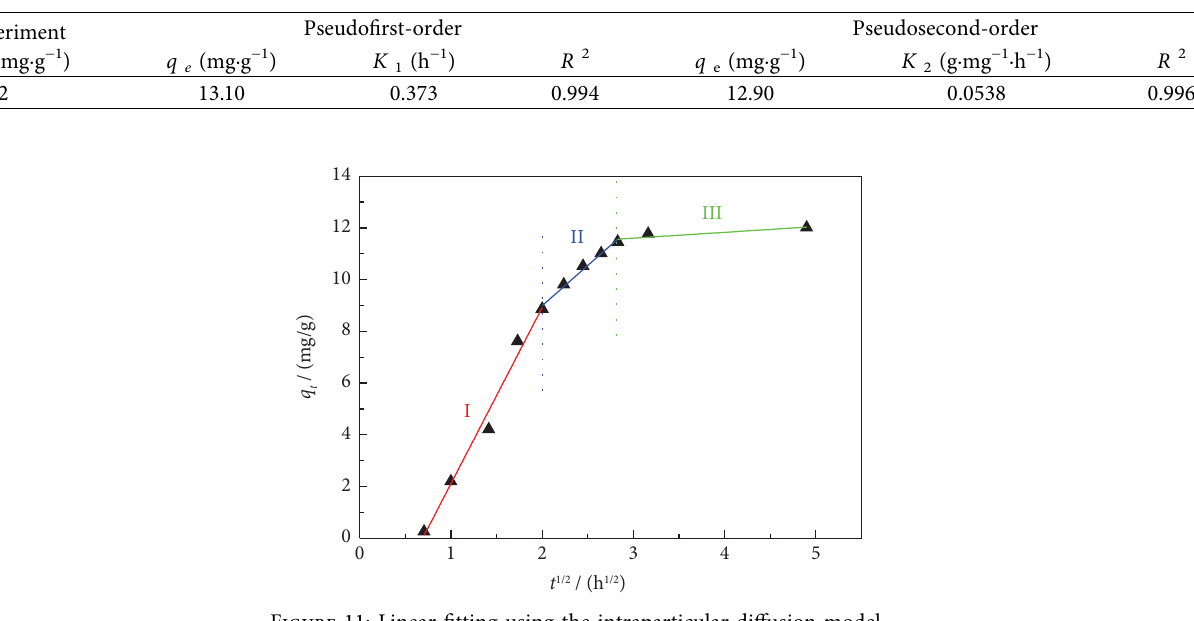
Figure 10: Plotting on pseudofrst-order (a) and pseudosecond-order (b). Table 4: Relative parameters of the pseudofrst/second-order models.